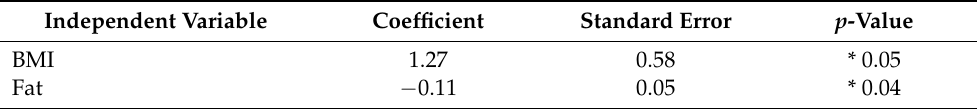
Table 10. Significant factors in the regression analysis of cortisol change after exercise in athletes (dependent variable) and sex, age, BMI, athlete, calories per BMR, sugar, proteins, fat, simple carbo- hydrates, and complex carbohydrates (independent variables) (adjusted R-squared 0.13). * p < 0.1. Independent Variable Coefficient Standard Error p -Value BMI 1.27 0.58 * 0.05 Fat − 0.11 0.05 *